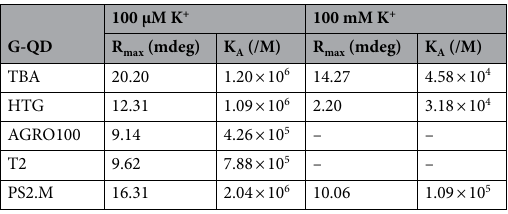
Table 3. Association constants of G-QDs for the binding of Pb 2+